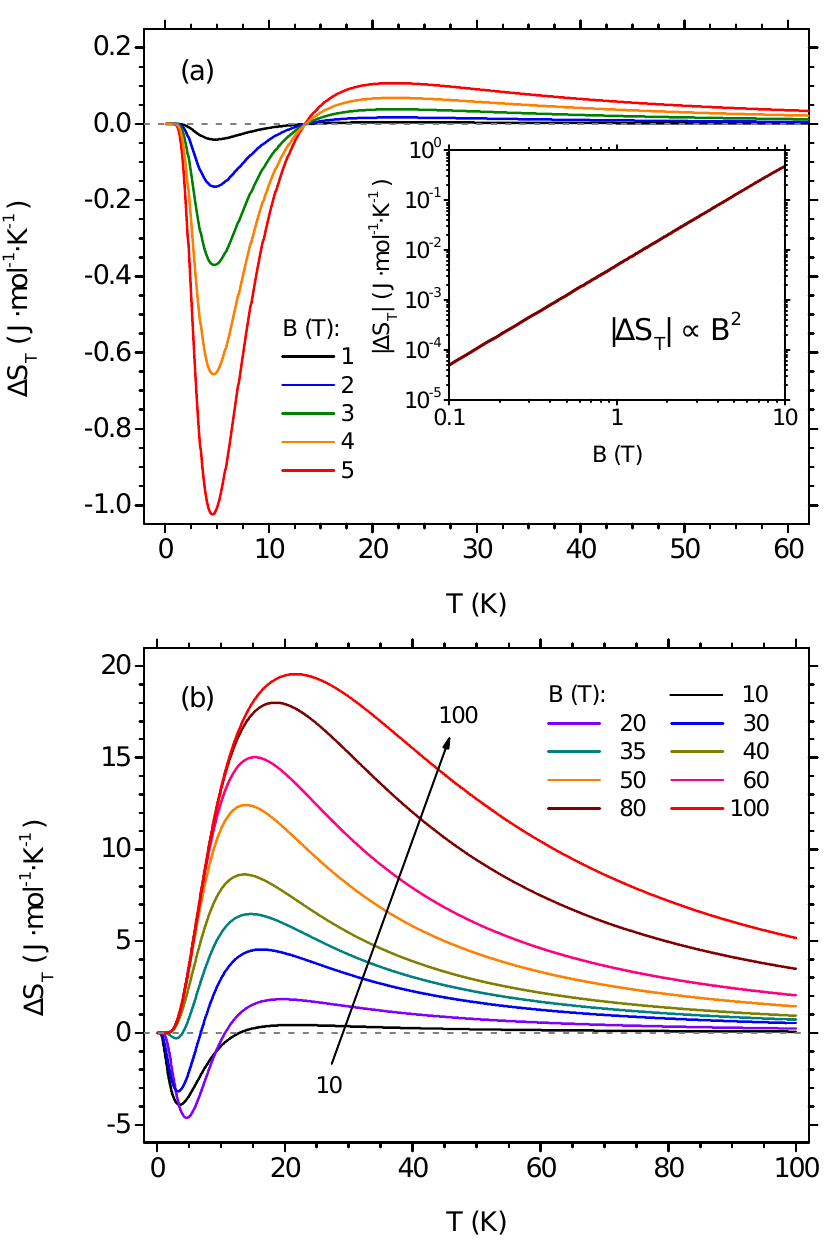
Figure 7. The dependence of the isothermal entropy change per mole on the temperature, for selected initial values of the external magnetic field in the isothermal process (the final value of the magnetic field is zero). ( a ) low-field range; ( b ) higher field range. The inset in ( a ) shows the absolute value of isothermal entropy change as a function of the initial value of the external magnetic field for the local minimum at approximately 5 K in double logarithmic